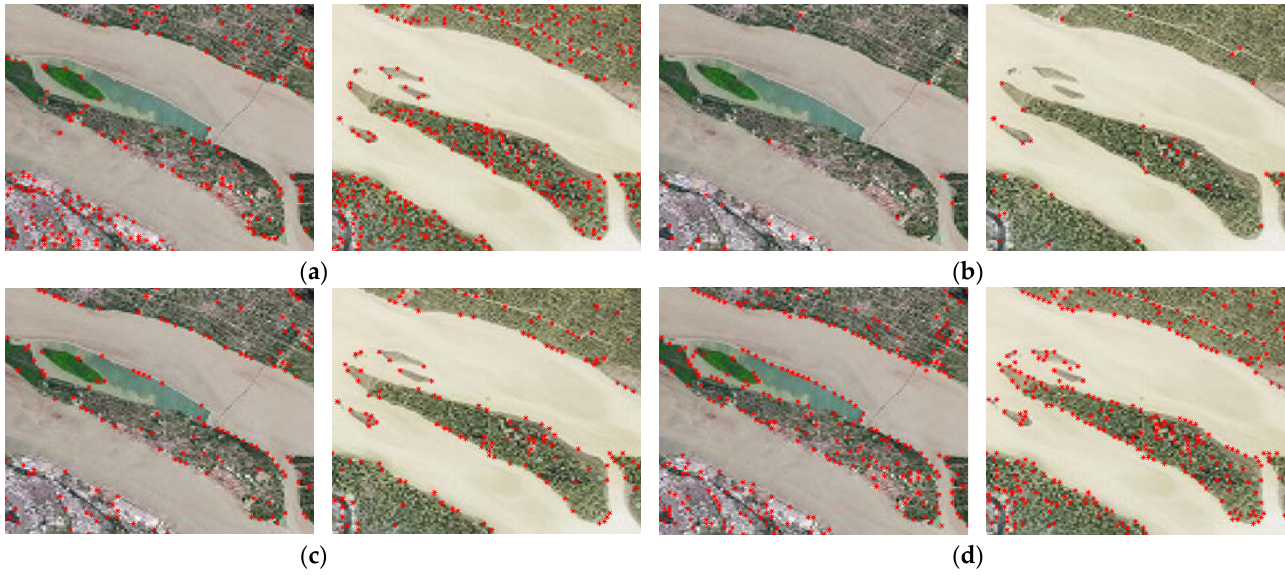
Figure 2. Feature detection results: ( a ) based on the original image; ( b ) based on the minimum moment map; ( c ) based on the maximum moment map; and ( d ) based on the weighted moment map.